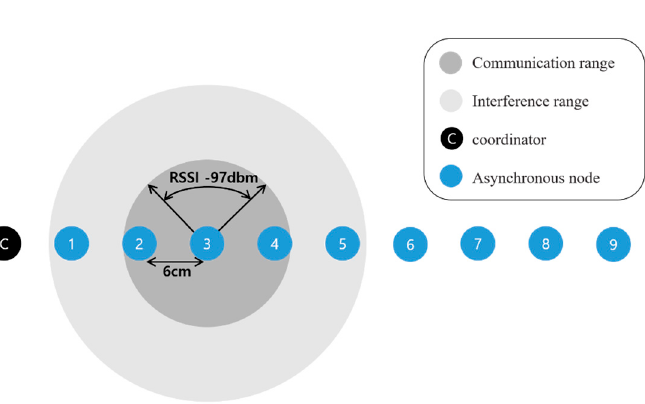
Figure 10. Nine-Hop Linear Topology.